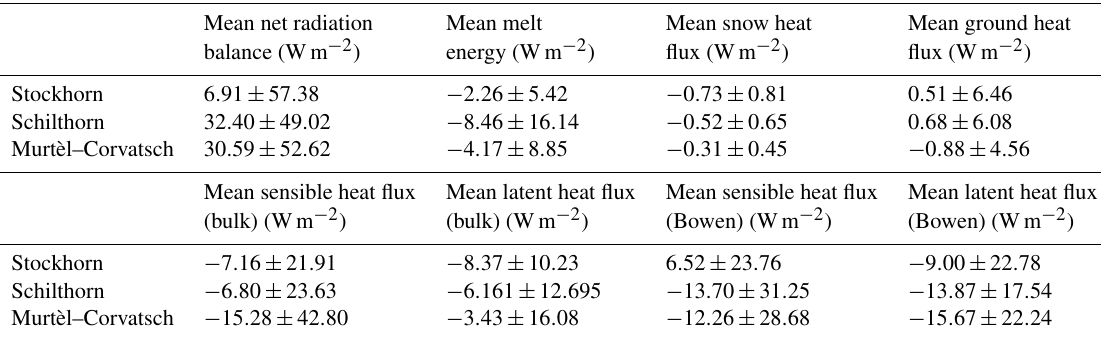
Table 4. Mean values and standard deviation for the energy balance components calculated based on the mean monthly values and the time period of